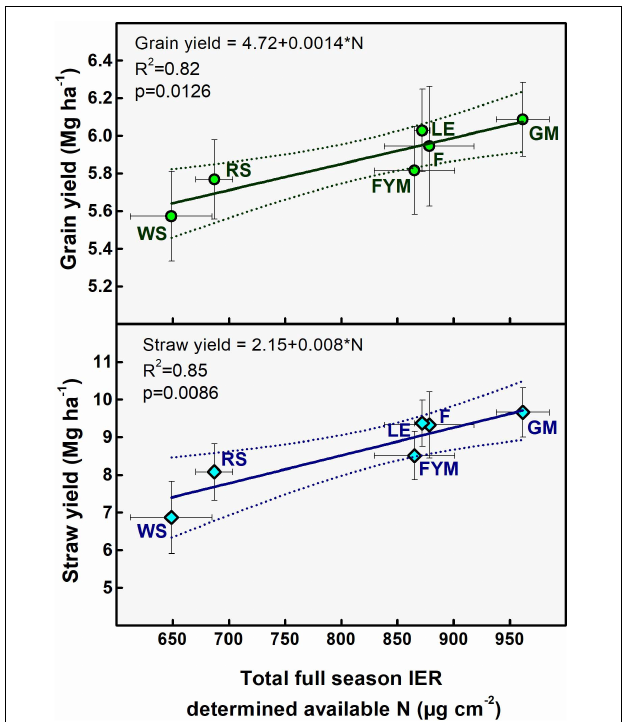
FIGURE 6 | Relation between full-season IER (ion exchange resin) determined plant-available nitrogen (N) and averaged grain and straw yields from 2011 to 2018. Vertical error bars denote ± 1SD and horizontal bars denote ± 1SD. Treatments are described in Figure 2 legend.